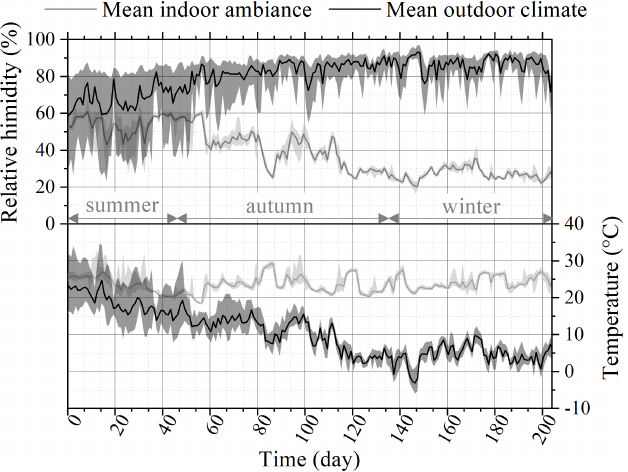
Figure 10. Evolution of the outdoor (black) and indoor (grey) relative humidity and temperature. Solid lines represent the daily mean measurements while shaded areas represent variations measured each day by sensors 1 and